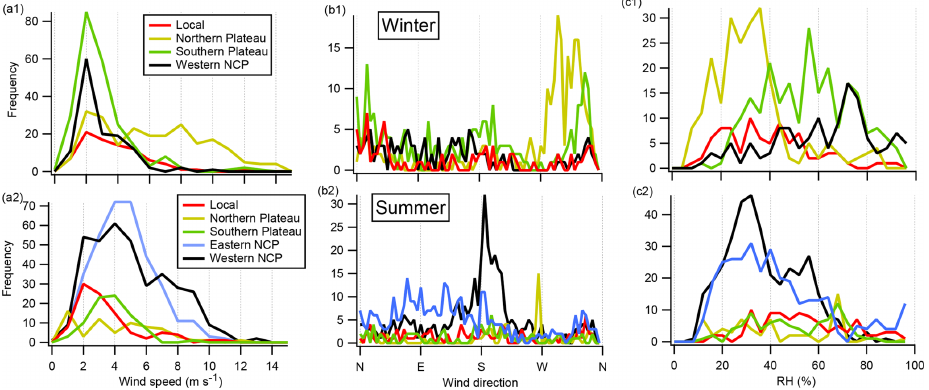
Figure 4. Frequency distributions of wind speed and direction ( z = 120m) and RH ( z = 8m) for classified air mass types in both